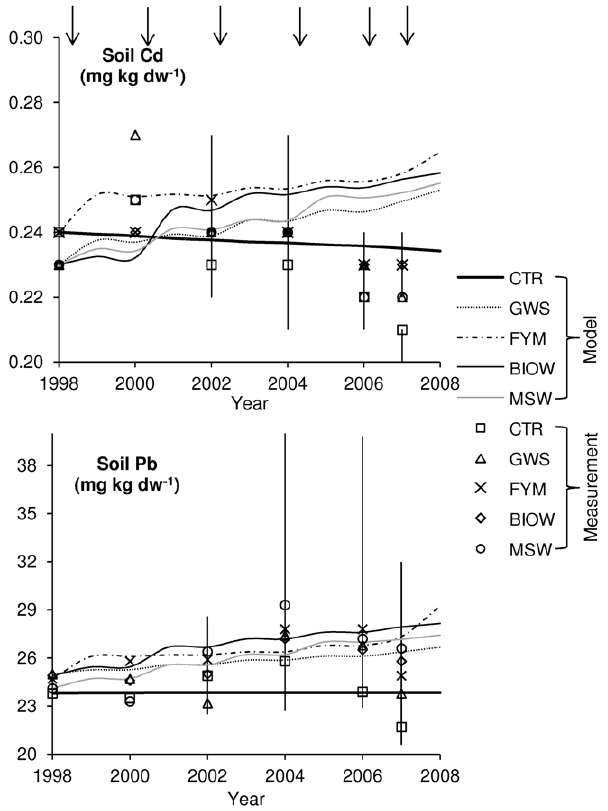
Figure 2. Comparison of predicted and measured concentra- tions in top soil for the five treatments. September 1998 to July 2007. Model predictions are connected by lines for clearer comparison to measured values. Vertical lines denote the range of measured values and arrows the time of amendment application. Measured concentra- tions represent median of four replicates.